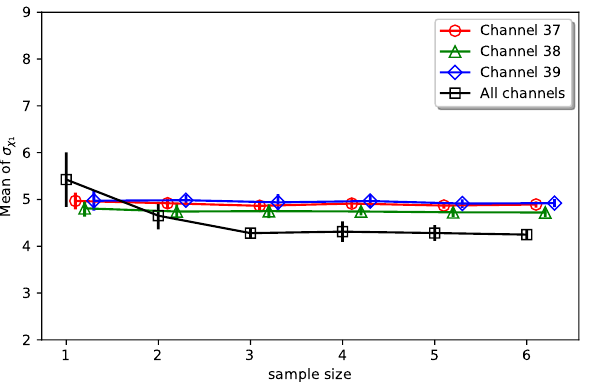
Figure 19. Mean of σ χ in the two-segment path loss models derived using the median of data 1 samples from six receivers. The vertical lines on each result data point in the figure represent the plus/minus standard deviation of σ χ over several repeated modeling processes using randomly 1 selected data